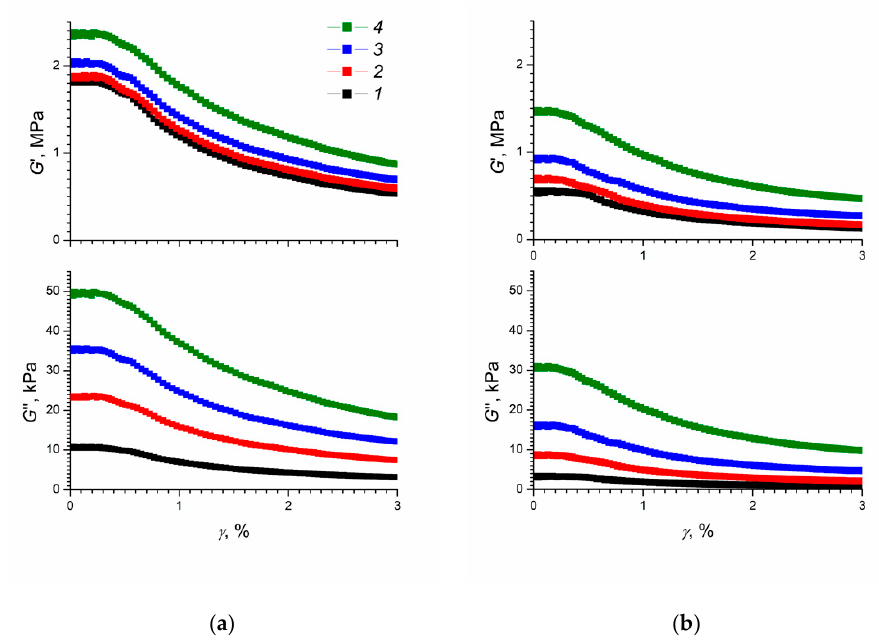
Figure 2. Storage modulus ( G (cid:48) ) and loss modulus ( G (cid:48)(cid:48) ) as functions of relative deformation in electric fields of various strengths (1–0 kV/mm; 2–0.4 kV/mm; 3–1.2 kV/mm; 4–2 kV/mm) for elastomer samples modified with titanium dioxide and vulcanized ( a ) in the absence of an electric field and ( b ) in an electric field. The shear rate was 0.1 rad/s.